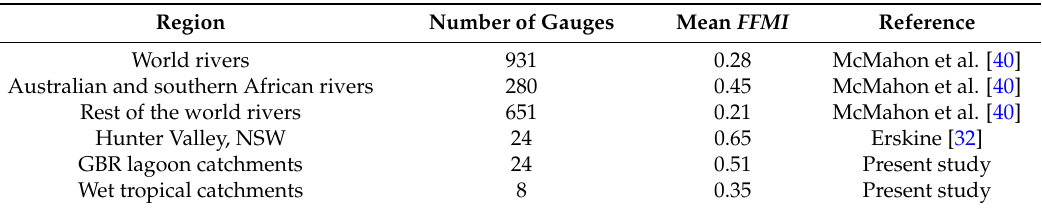
Figure 3. FFMI for the GBR lagoon catchments. Table 3. Flood variability indices for the GBR lagoon catchments compared to the rest of Australia and world rivers.